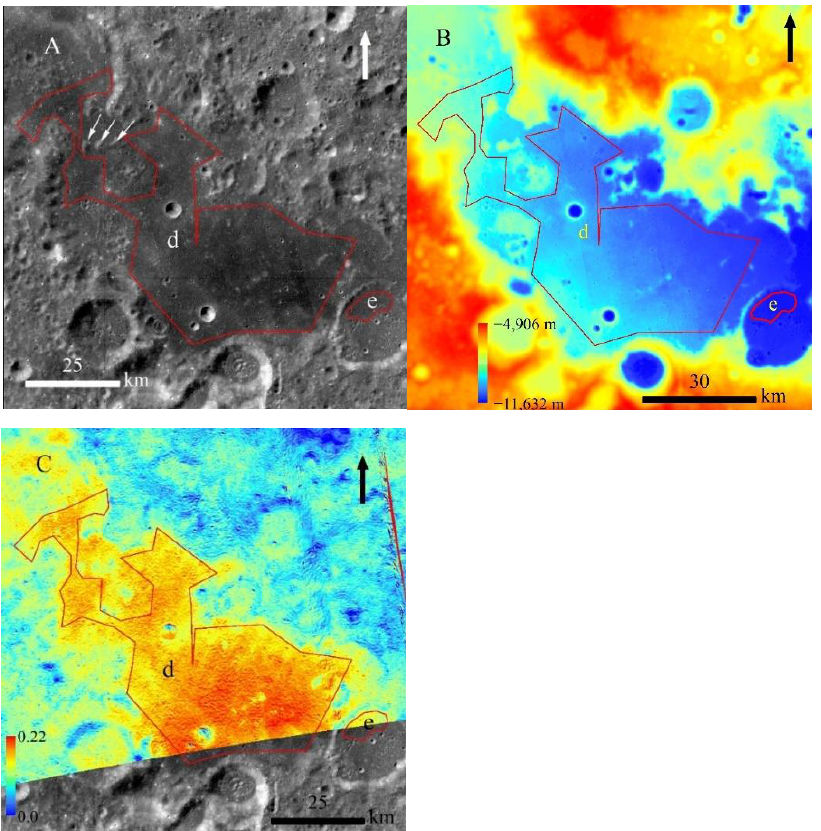
Figure 4. Two basalt measurement areas d (2320 km 2 ) and e (59 km 2 ) mapped by red polygons in Von Kármán M crater. ( A ) CE-2 DOM mosaic (central location: 173.6° E, 48.76° S) of the Von Kármán M crater. The raised massifs are indicated by the white arrows. ( B ) Local topography shown in SLDEM, and the elevation ranges from − 11,632 m to − 4906 m as coded from blue to red in this figure. ( C ) FeO content map [24] in Von Kármán M crater, and the maximum value is up to 22.28% as coded from blue to red in this figure. The red polygon in each sub-figure is the outlined representative crater count area. North is up in all sub-figures.